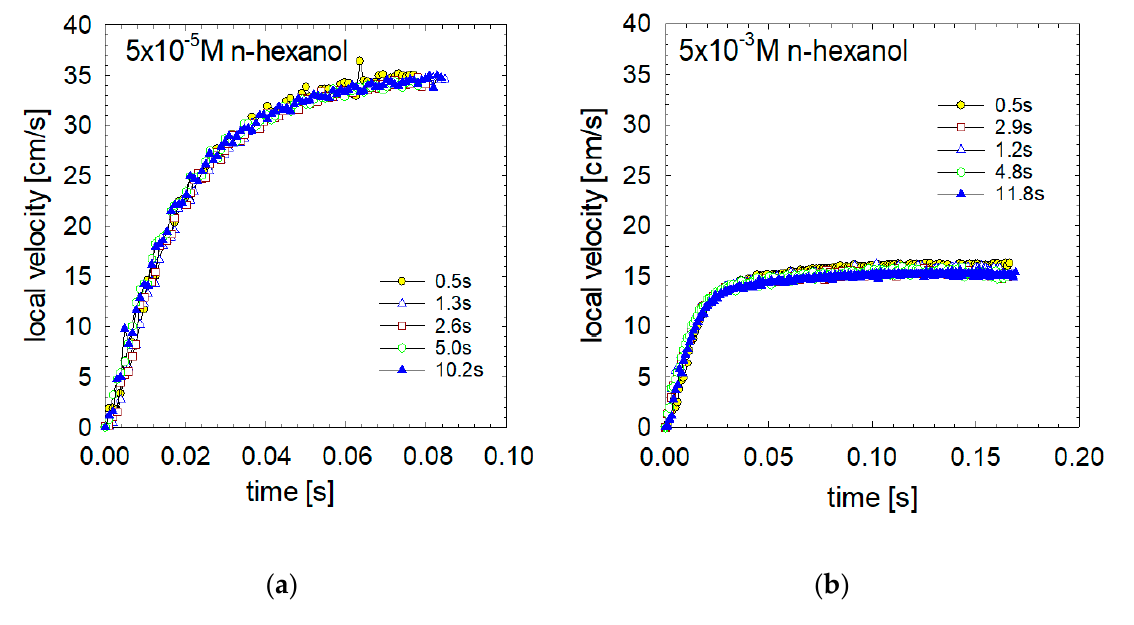
Figure 5. Detailed velocity profiles (for acceleration stage of motion) in n-hexanol solutions ( a ) 5 × 10 − 5 M and ( b ) 5 × 10 − 3 M as a function of the detachment time.